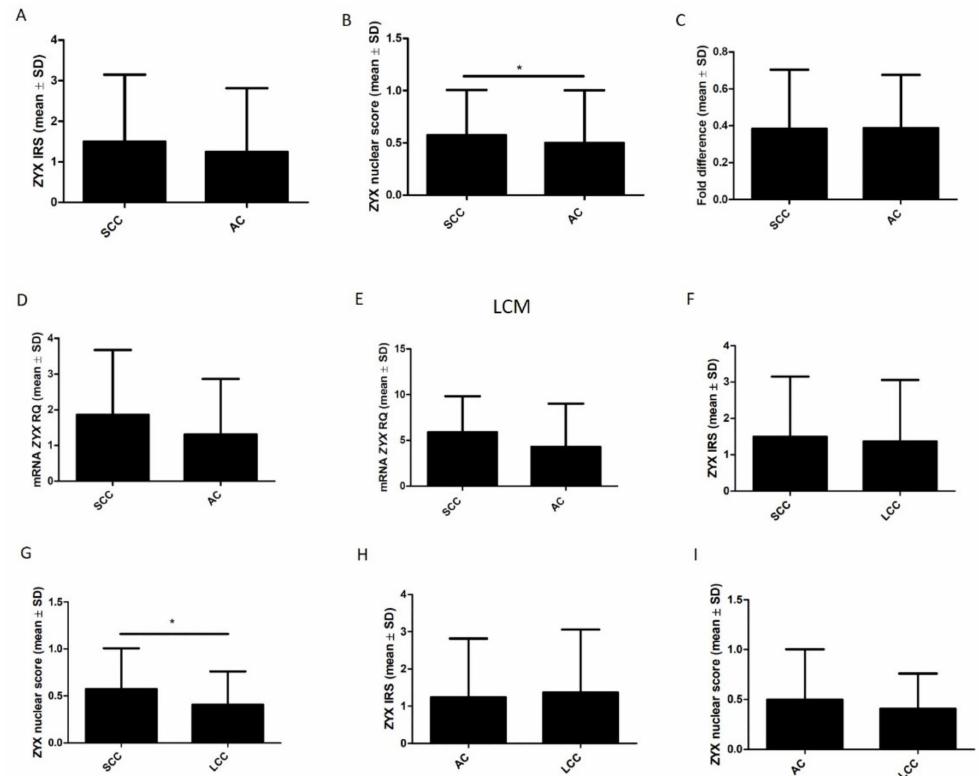
Figure 8. Comparison of zyxin expression in lung SCCs and lung ACs using the following methods: immunohistochemistry ( A , B ); Western Blot ( C ); real-time PCR ( D ); and real-time PCR performed on tumor cells isolated using laser capture microdissection (LCM) ( E ). Mann–Whitney test (IHC, RT-qPCR) and unpaired t-test (Western Blot, LCM real-time PCR) (* p < 0.05). Comparison of zyxin expression in lung LCCs and other NSCLC subtypes (SCC, AC) with the use of IHC ( F – I ). Mann–Whitney test (* p <